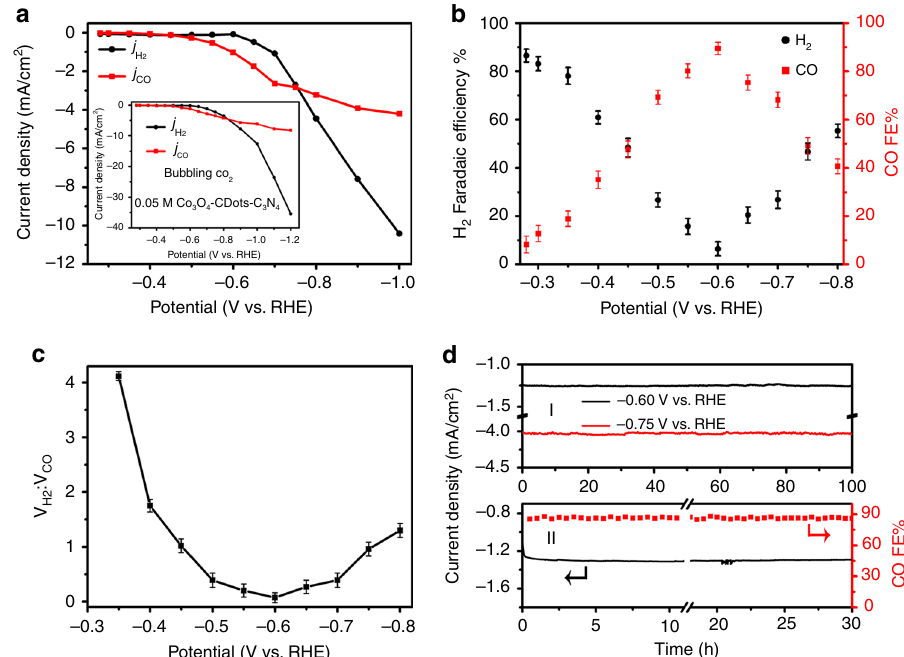
Fig. 3 Electroreduction of CO 2 and H + /H 2 O to syngas with adjustable H 2 /CO ratio. a The current density for HER ( j H2 , black trace) and for CO 2 reduction, ( j CO , red trace) vs. the applied potential, catalyzed by Co 3 O 4 -CDots-C 3 N 4 in CO 2 -saturated 0.5 M KHCO 3 electrolyte. The inset shows the same experiment conducted with bubbling of CO 2 to the solution to overcome CO 2 consumption during the experiment. b The FEs of the reduction of CO 2 to CO (red points) and H + to H 2 (black points) catalyzed by Co 3 O 4 -CDots-C 3 N 4 vs. the applied potential. Experiments were performed in triplicates and results are shown as mean ± standard deviation. c The volume ratio between H 2 and CO vs. the applied potential. The H 2 /CO volume ratio is about 1:1 at the potential of − 0.45 V or − 0.75 V vs. RHE. d The stability of the performance of Co 3 O 4 -CDots-C 3 N 4 for producing syngas: operated at potentiostatic potential of − 0.6 and − 0.75 V for 100 h ( d Ι ); operated at potentiostatic potential of − 0.6 V for 30 h ( dII ): current density vs. time (left axis) and FEs of CO production vs. time (right